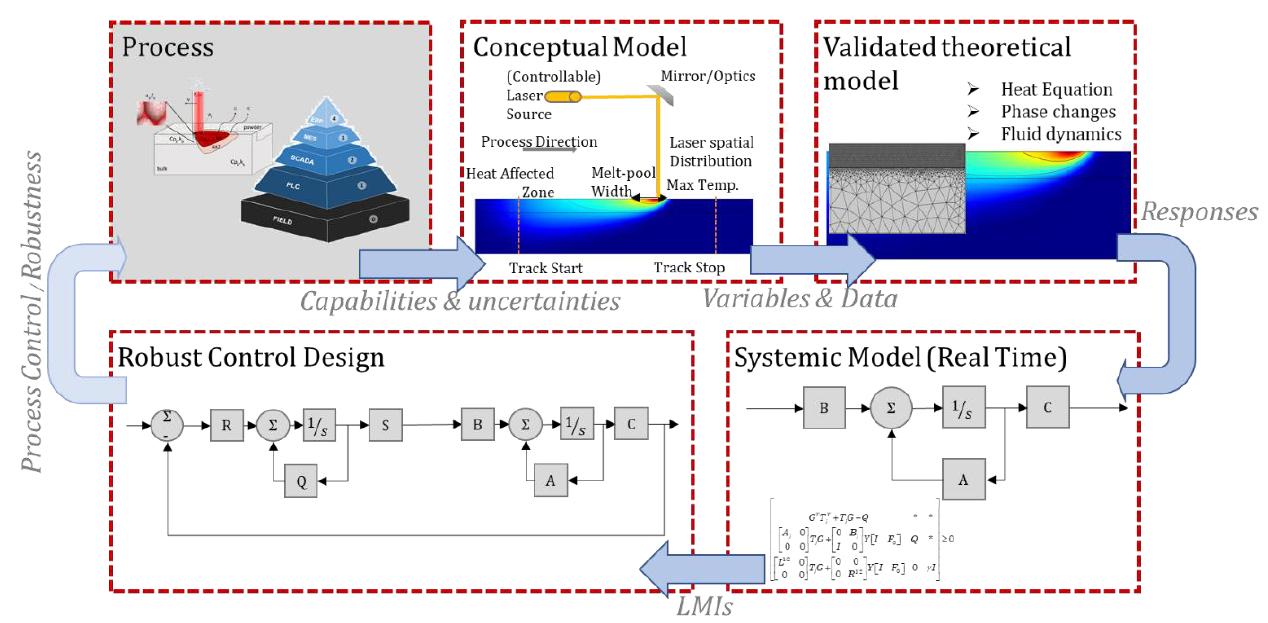
Figure 5. Synthesis of robust controller utilizing LMIs.